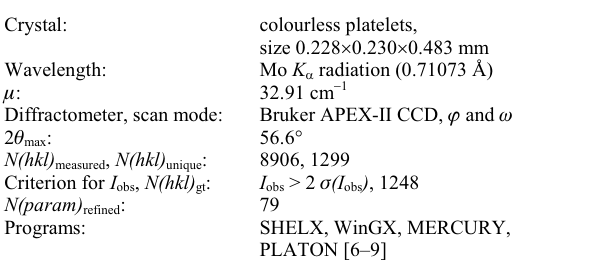
Table 1. Data collection and handling.